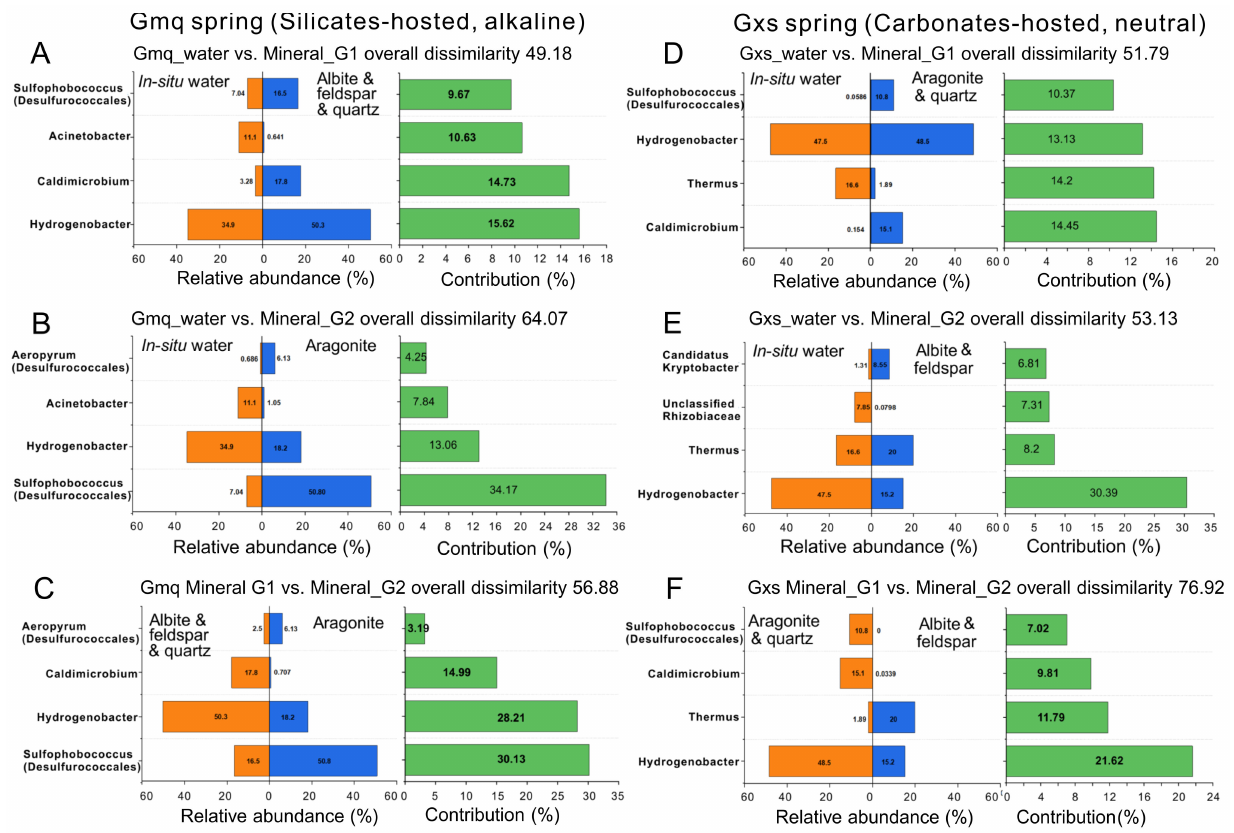
Figure 5. Taxonomic genera that contributed to up to 50% of the overall dissimilarities between paired groups in the Gmq and Gxs springs. ( A ) Gmq_water versus Mineral_G1 (Albite, K-feldspar, and quartz); ( B ) Gmq_water versus Mineral_G2 (aragonite_250 and aragonite_500); ( C ) Mineral_G1 versus Mineral_G2 in the Gmq spring; ( D ) Gxs_water versus Mineral_G1 (aragonite_250, aragonite_500 and quartz); ( E ) Gxs_water versus Mineral_G2 (Albite and K-feldspar); ( F ) Mineral_G1 versus Mineral_G2 in the Gxs